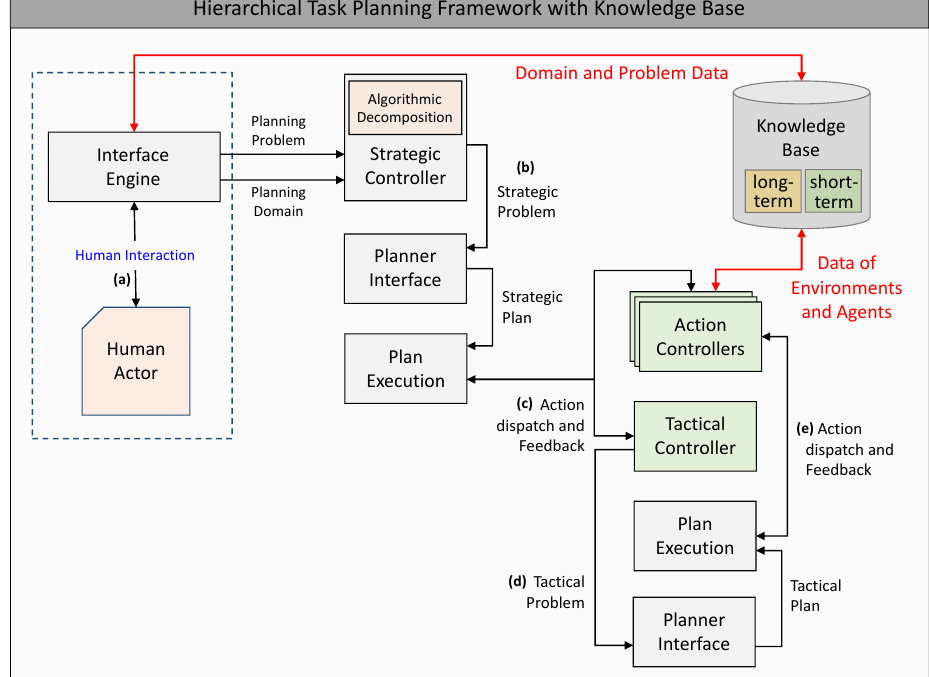
Figure 4. Hierarchical task planning framework with a knowledge base: The strategic level and tactical level each consist of the controller, planner interface, and plan execution. The environment and agent data required for planning are saved in the knowledge base, based on which the PDDL domain and problem are automatically generated in the interface engine.